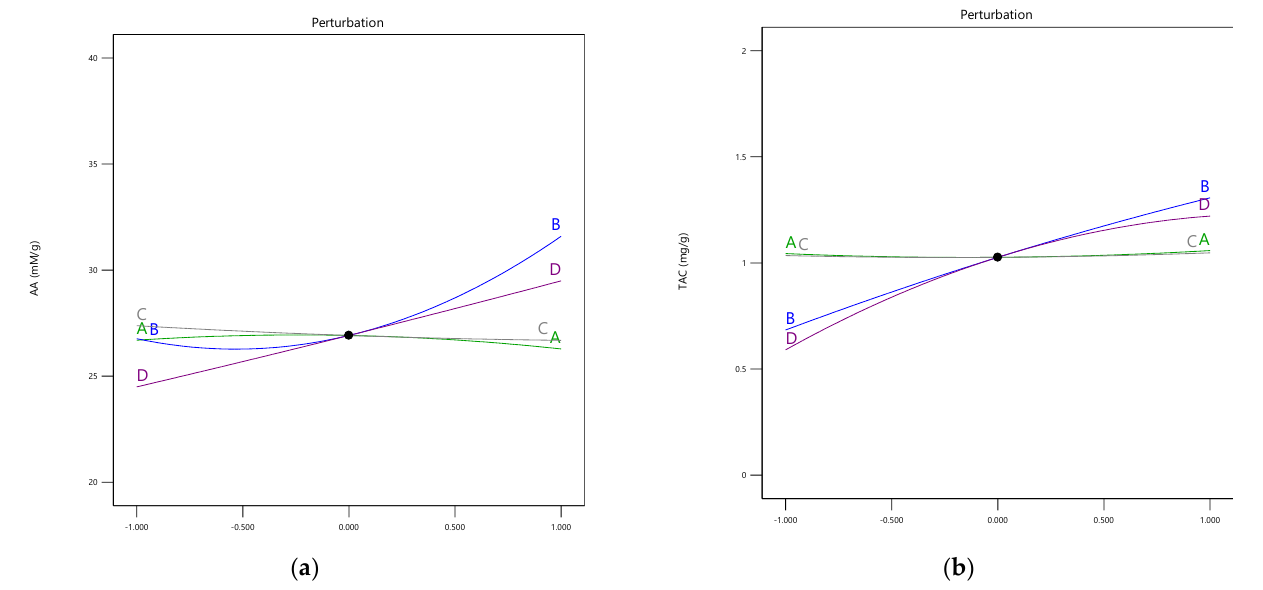
Figure 2. Perturbation graphs representing the effect of each independent variable (A, B, C, and D) on AA ( a ) and TAC ( b ) of the red onion skins extract.